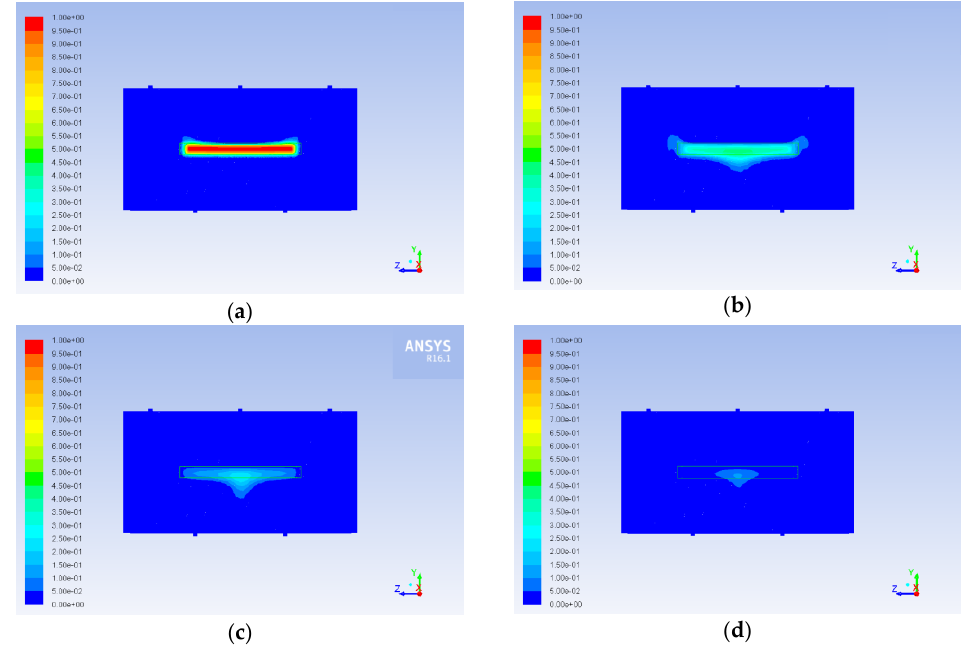
Figure 16. Aniline mass fraction profile (YZ middle cross section, the reactor walls are not shown, maximum value of the color map corresponds to pure aniline): ( a ) 500 s, ( b ) 10,000 s, ( c ) 20,000 s, ( d ) 30,000